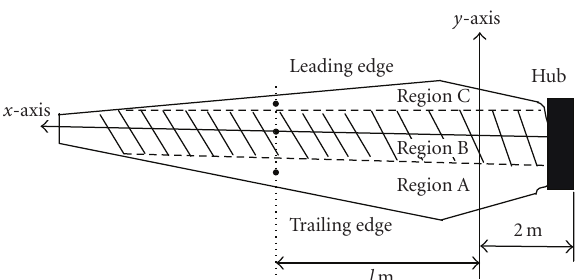
Figure 1: 2D Schematics of the blade (hatched area indicates region with interior box